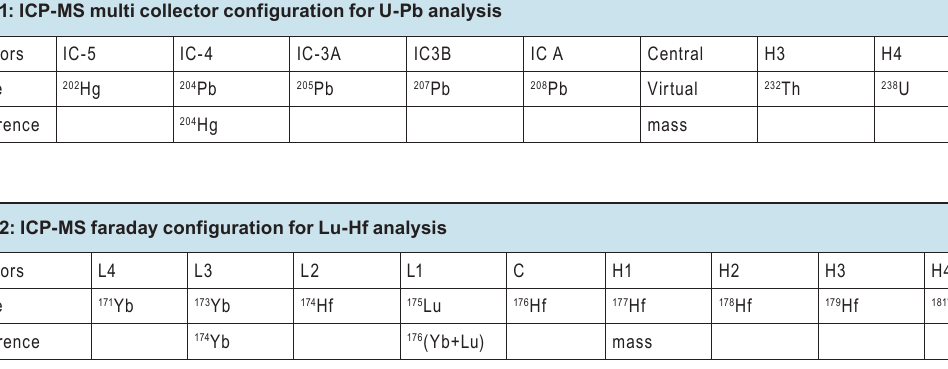
Table 1: ICP-MS multi collector configuration for U-Pb analysis Collectors